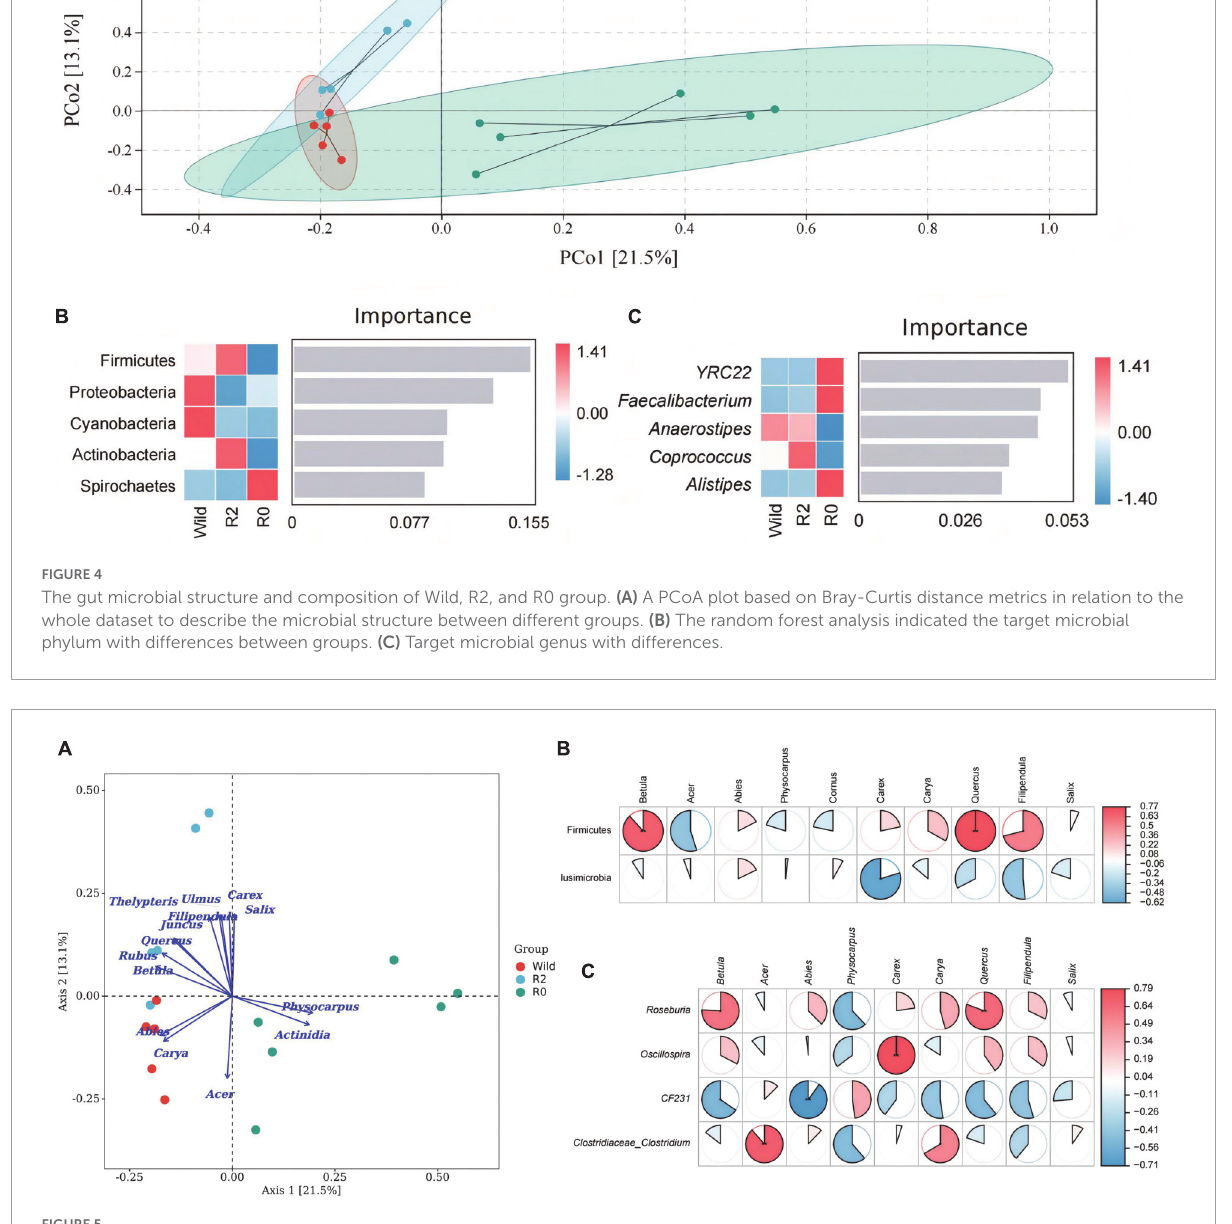
FIGURE5 The relationship between feeding plants and gut microbes. (A) The PCoA plot based on environment variables fitted to the unconstrained coordinate axis; dots represent the microbial community, arrows represent plant species, dot color represents different groups. (B) Microbial phylum associated with feeding. (C) Microbial genus associated with